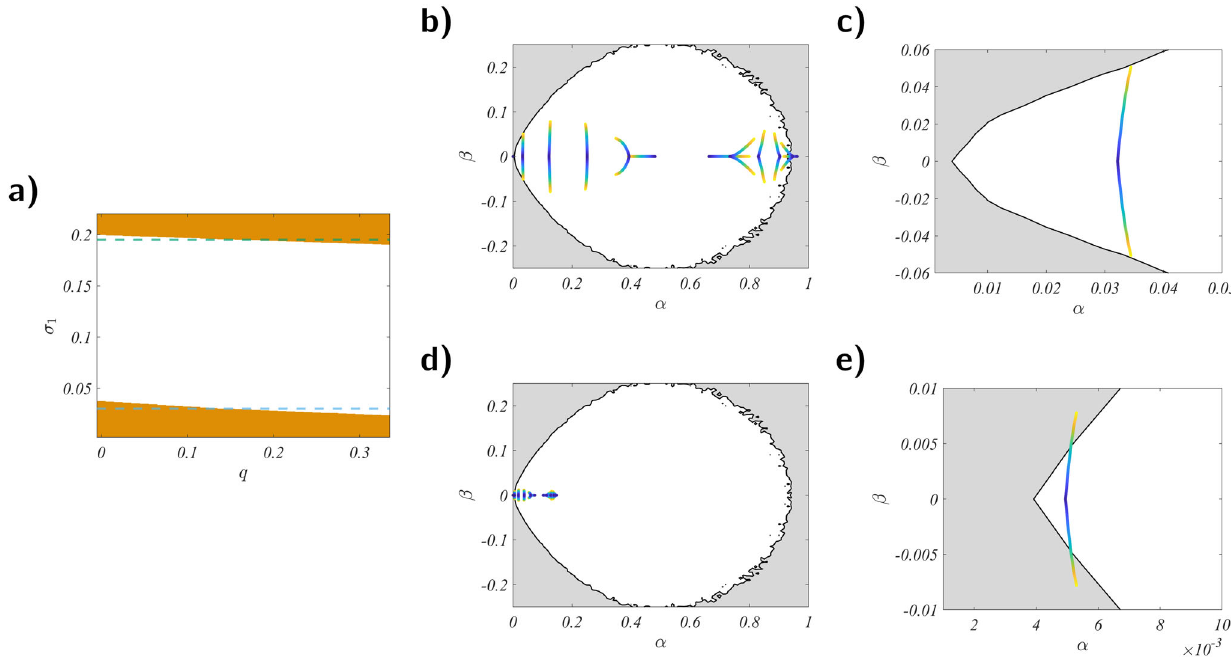
Fig. 3 Directionality induced (de)synchronization with an alternative symmetrization method. a Synchronization diagram in the plane ( q , σ 1 ) for a system of Rössler oscillators with x - x cubic coupling. q is the symmetrization parameter, such that we have a directed hypergraph for q = 0, while we get an undirected sturcture for q = 1/3. σ 1 is the coupling strength of the pairwise interactions. The white area indicates the region of stability, while the orange one the region where synchronization is lost. The horizontal dashed lines represent two values of σ 1 for which the system transits from a synchronized to an unsynchronized state as a function of q (green line), and the other way around (blue line). Panels b – e display the locus of eigenvalues of the effective Laplacian matrix M as a function of q , for a hypergraph with N = 20 nodes at two different values of σ 1 (color coding is such that the directed case q = 0 is represented in yellow, and the symmetric one q = 1/3, in blue). In the background, the white area indicates the region where the Master Stability Function (MSF) is negative, the black line the boundary of this region, and the gray area the region with positive MSF. Panels c and e represent a zoom of the area close to the origin of panels b and d , respectively. Panels b and c display a setting where the symmetric topology drives the system unstable, starting from a directed hypergraph for which the synchronization manifold is stable. Panels d and e show a case for which the symmetric topology admits a stable synchronization state, while the directed hypergraph drives to instability. The coupling strength for panels b and c is fi xed to σ 1 = 0.195, while for panels d and e to σ 1 = 0.03. In both cases we set the ratio r 2 = σ 2 / σ 1 = 0.7, being σ 2 the coupling strength of the three-body